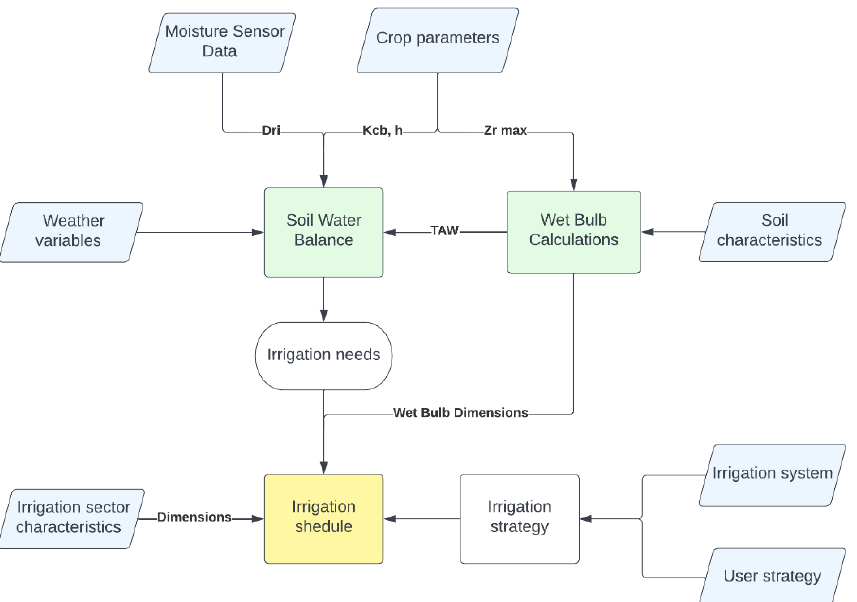
Figure 6. General outline of the proposed irrigation model. AEMET is the Spanish State Meteorological Agency, and elTiempo.es is a Spanish website where weather forecasts are shown.